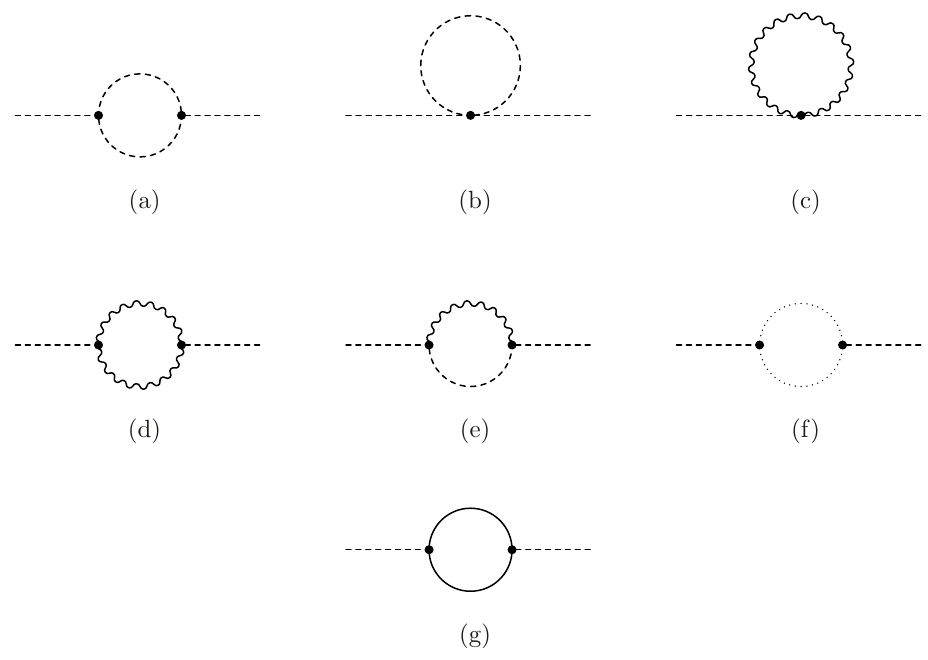
Figure 2. The Feynman diagrams contributing the scalar self-energy in the broken phase. In addition to the lines explained in figure 1, in diagram (f) we have dotted lines indicating ghost